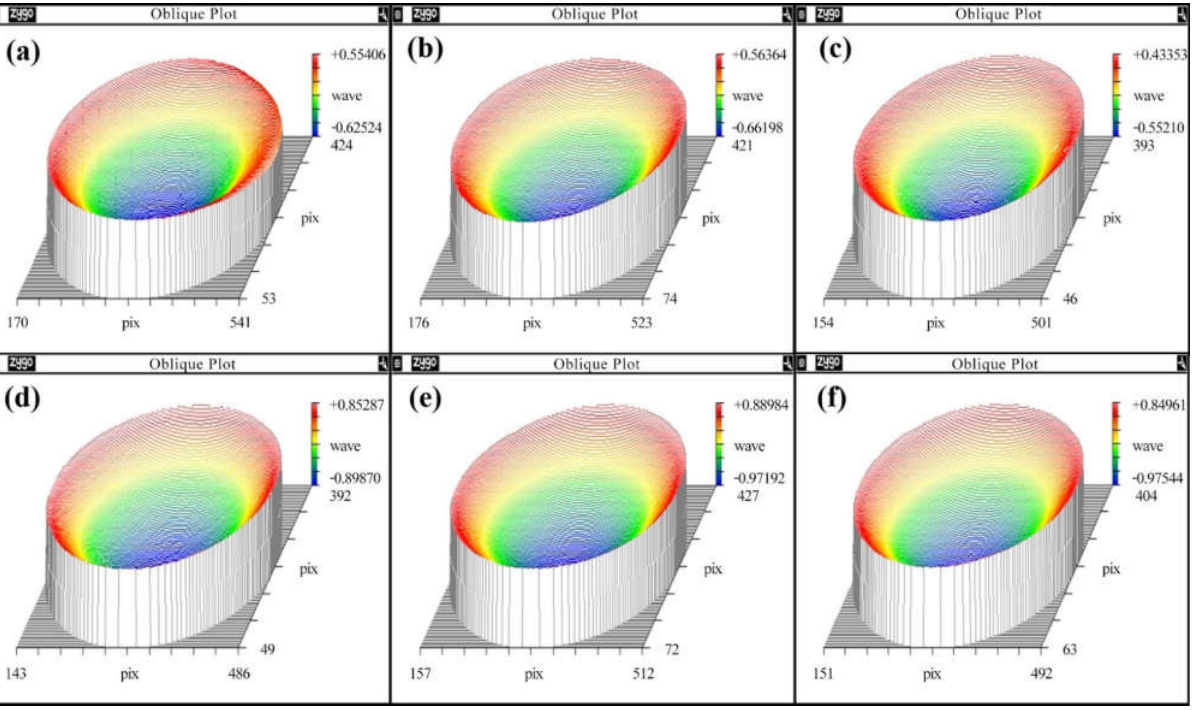
Figure 8. Surface shape of the YbF 3 film deposited at different ion energies. ( a ) 0 eV before coating. ( b ) 180 eV before coating. ( c ) 360 eV before coating. ( d ) 0 eV after coating. ( e ) 180 eV after coating. ( f ) 360 eV after coating.